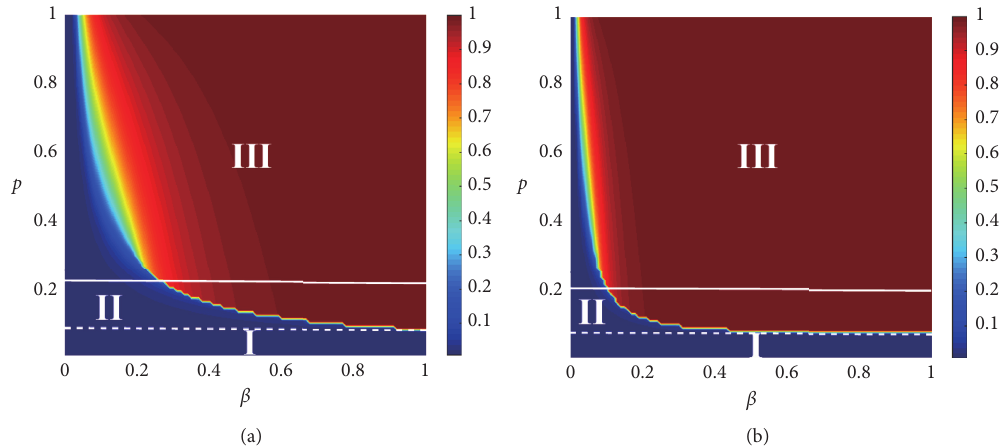
Figure 4: The combined effects of unit propagation probability β and the fraction of fashionable individuals p on the individual final adoption size for weighted ER network. In subgraphs (a) ( α phase transition, and continuous phase transition in regions I, II, and III, respectively. Other parameters are ρ